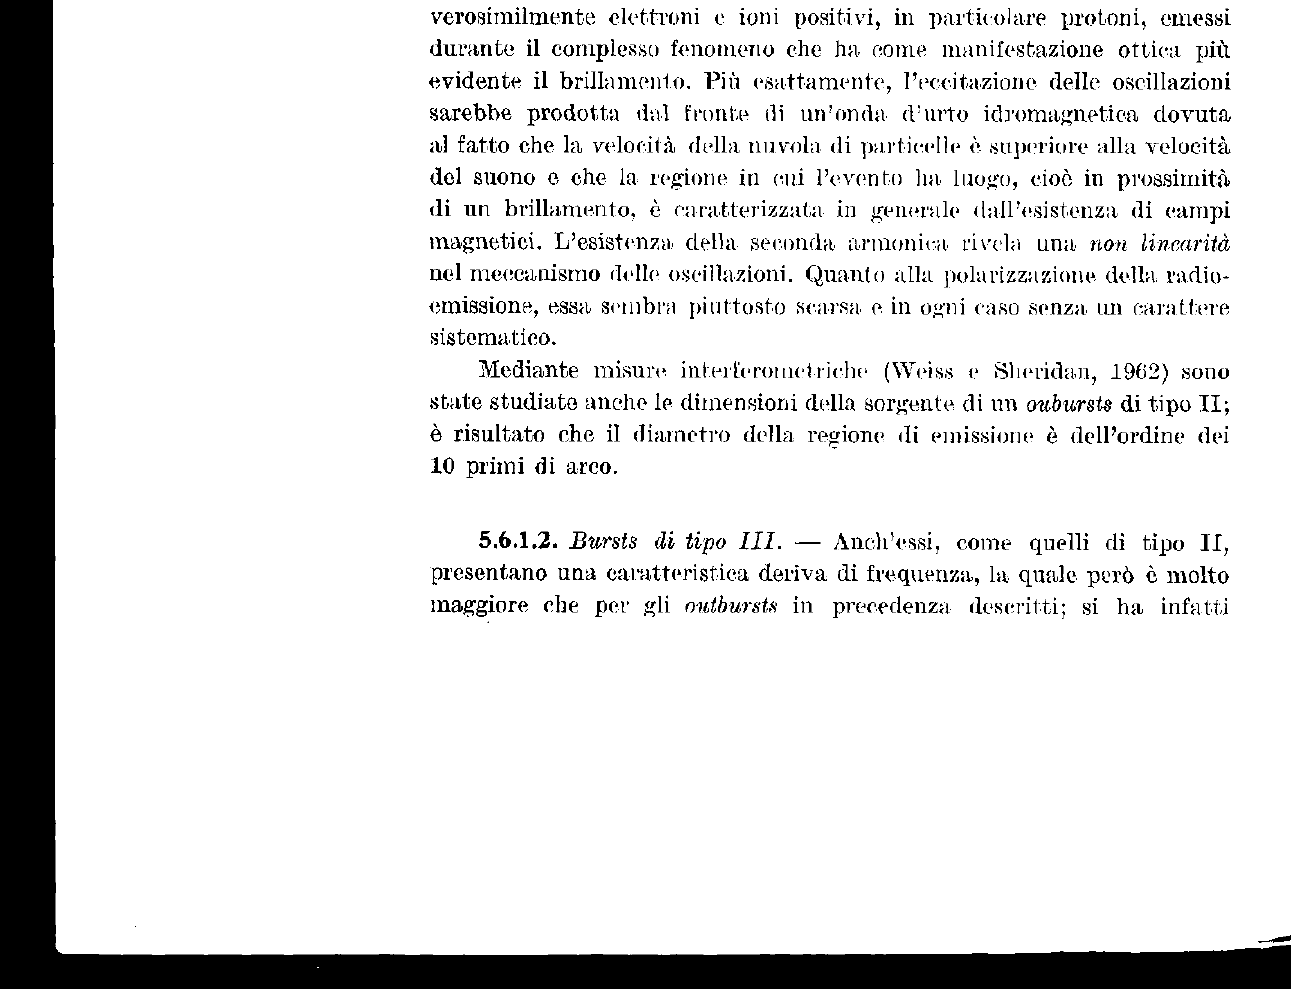
Fig. 5.40 - Velocità radiale media delle perturbazioni origine degli outbursts di tipo II (secondo Maxwell e